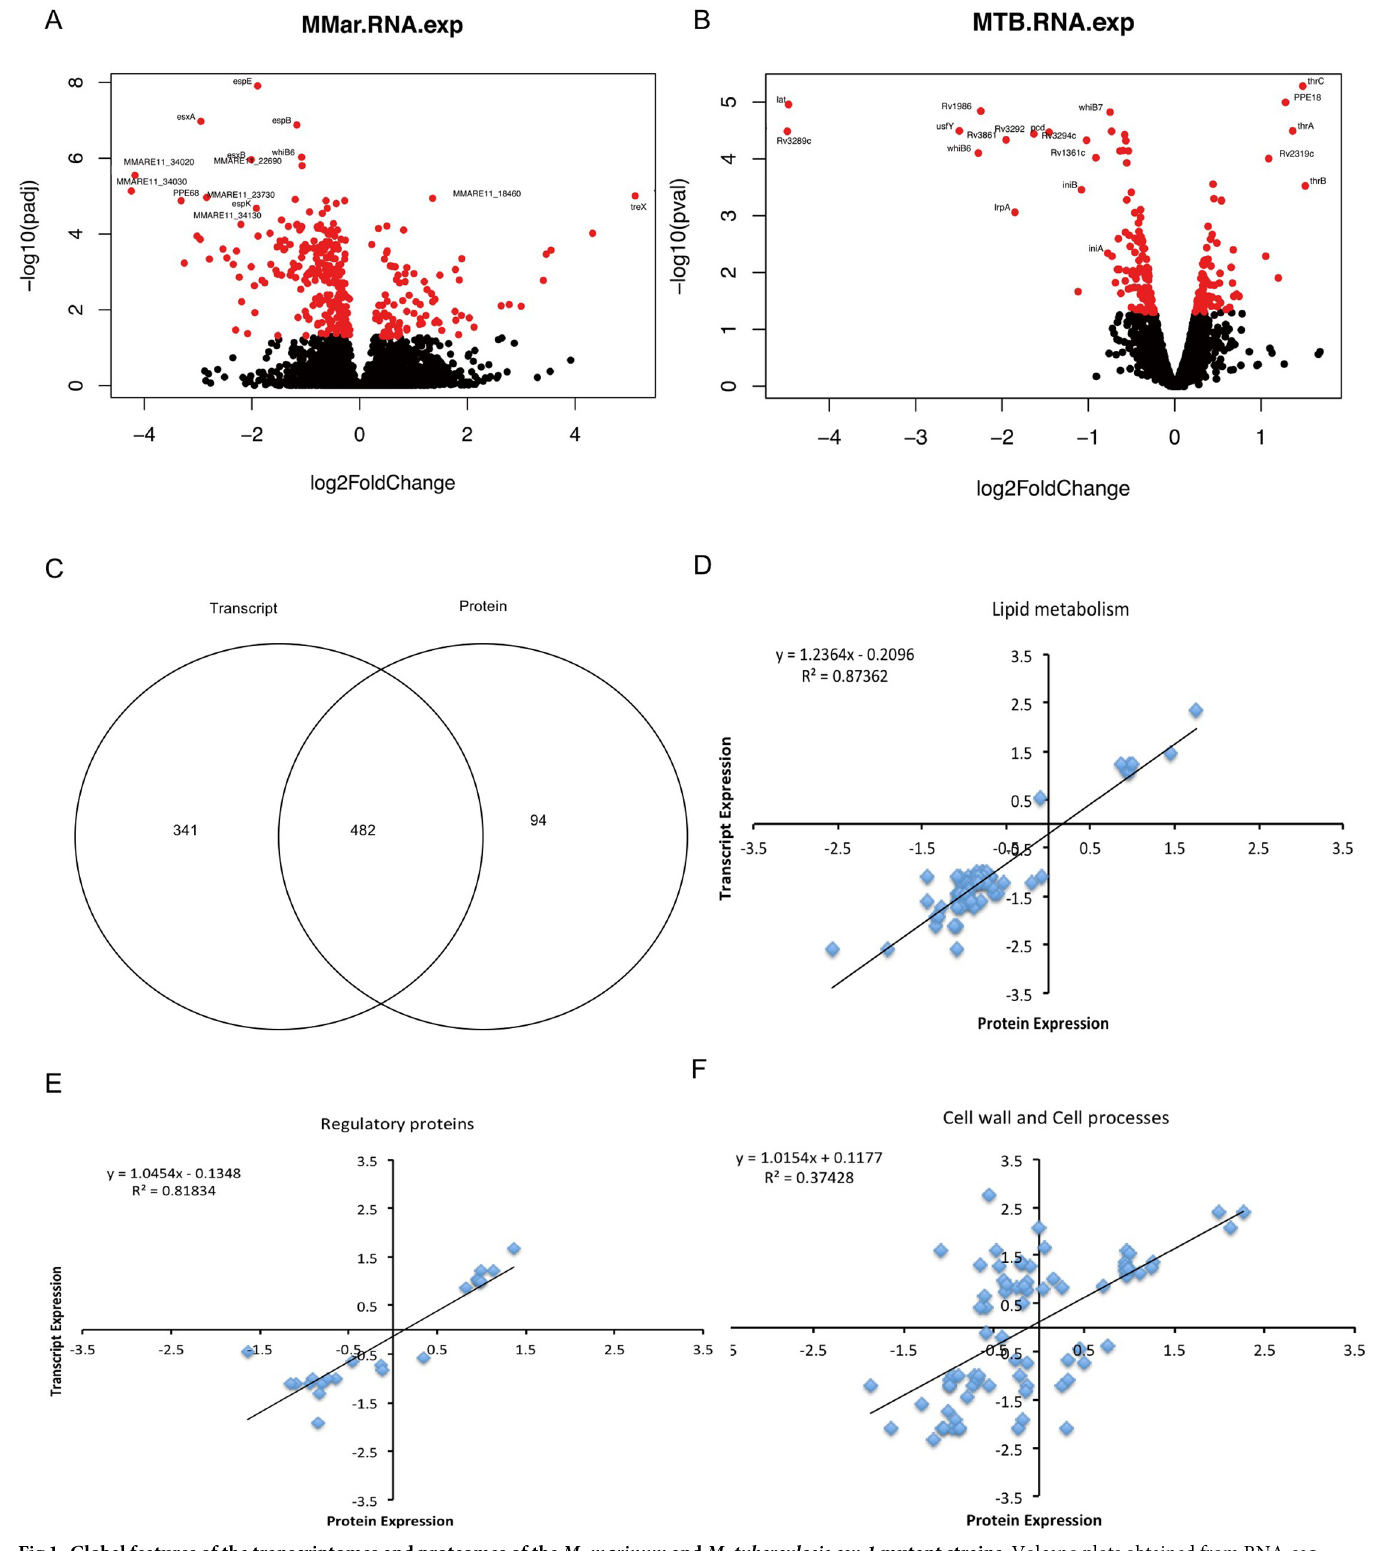
Fig 1. Global features of the transcriptomes and proteomes of the M . marinum and M . tuberculosis esx-1 mutant strains. Volcano plots obtained from RNA-seq analysis of the wild-type M . marinum E11 strain vs. the eccCb transposon mutant (A) and of M . tuberculosis mc 2 6020 vs. the esx-1 mutant strain (B). Each dot indicates 1